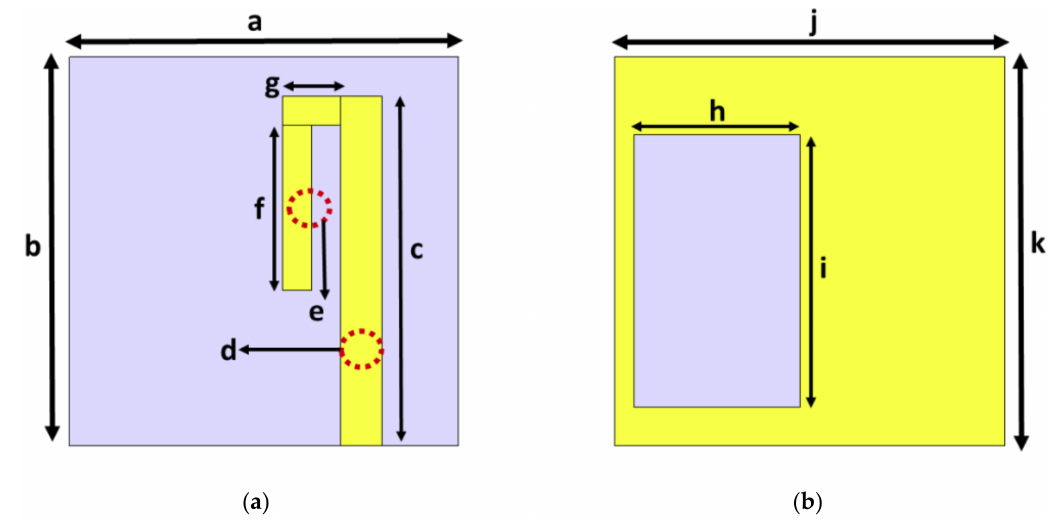
Figure 1. Proposed antenna design: ( a ) Front ( b ) Back.